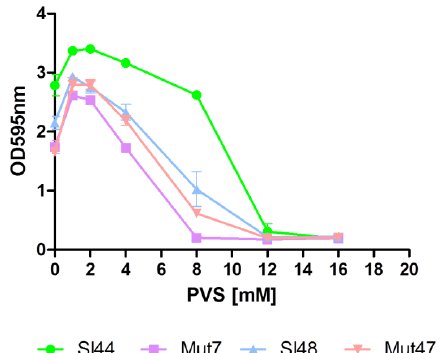
Figure 7. Effect of the sortase A inhibitor phenyl vinyl sulfone (PVS) on biofilm formation. The minimum inhibitory concentrations (MIC) of the sortase inhibitor PVS of S. lugdunensis wild type (SL44 and Sl48), ∆ srtA mutant (Mut7 and Mut47) were found about 12 mM. Data are presented as mean adsorptions of triplicate determinations. Single representative experiments out of three are presented. Error bars show standard deviations (SD).